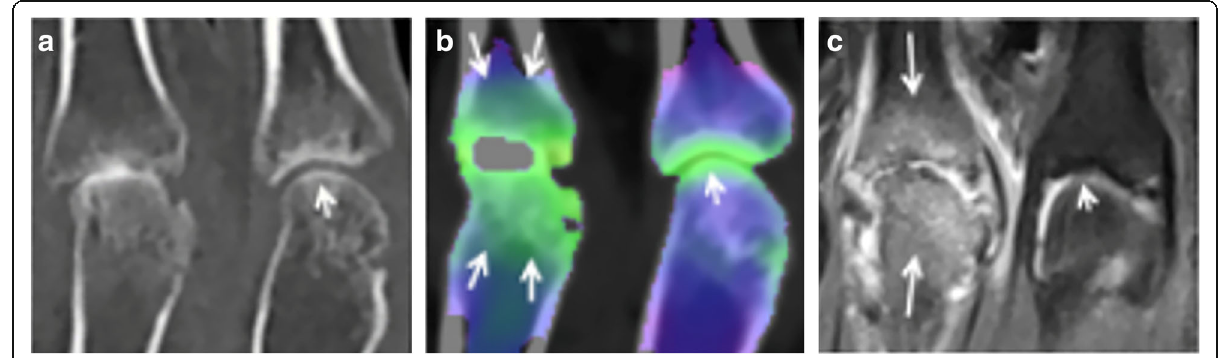
Fig. 6 Dual-energy computed tomography scan of hands in a patient with rheumatoid arthritis. Magnification on the second metacarpophalangeal joint shows a normal and smooth outline of cartilage and bone plate ( short arrows ) on standard grayscale series ( a ) and normal virtual non-calcium attenuation ( b ). Conversely, bone marrow edema is evident on the third metacarpophalangeal joint presenting as an extensive and ill-defined green area ( long arrows ). Magnetic resonance imaging by means of T2-weighted fat-saturation sequence confirmed the presence of inflammatory bone marrow edema ( c ). From Jans et al.